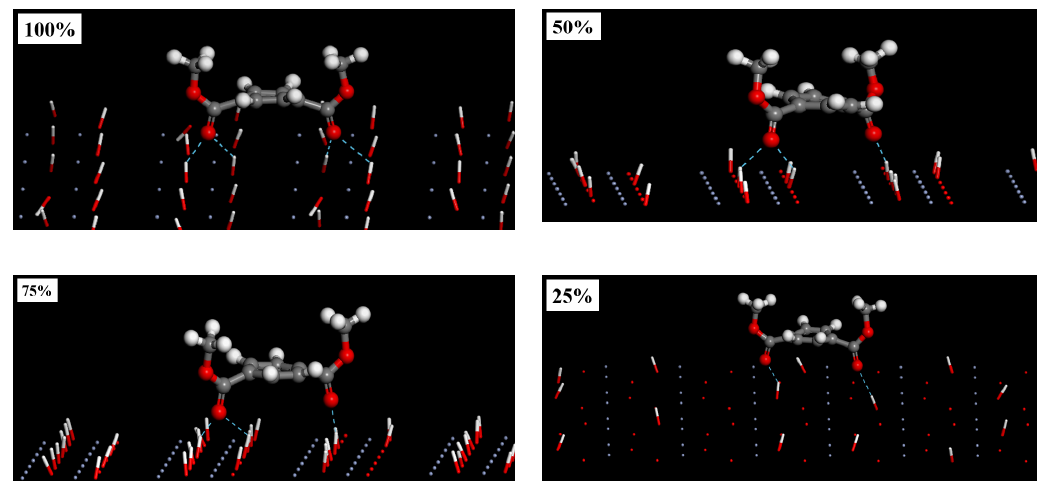
Figure 17. Side view of PET molecule complexation with Cr 2 O 3 with different hydroxyl concentration (the cyan dotted line represents the hydrogen bond).